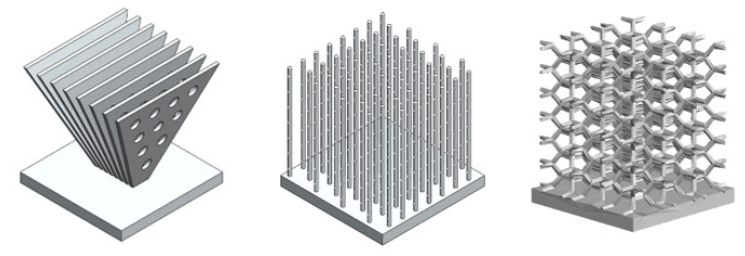
Figure 17. Fins, pins, and lattice heat sinks, respectively. tained for the lattice heat sink with hexagon unit cell. The pressure drop increased more than double for the same inlet velocity and Reynolds number, a consequence of the high frontal area. Even so, a decrease of about 28% and 9% in heat sink temperature was achieve, source temperature are kept constant during the experiments, the best heat sink is the one whose temperature is minimal, which, according to Equation (3), translates into lower thermal resistance. Table 11. Direct comparison between heat sinks with fins, pins, and blades (Re = 12,500). Model Total Are (cm 2